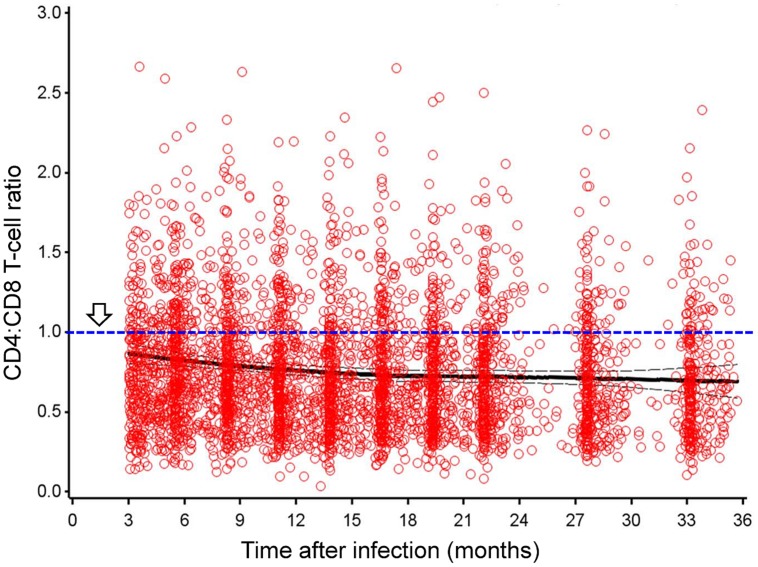
CD4:CD8 T-lymphocyte ratio in early human immunodeficiency virus type 1 (HIV-1) infection, in the absence of antiretroviral therapy. Results are shown for 499 seroconverters (SCs; native Africans) with 4,144 person-visits during the 3- to 36-month period after estimated date of infection. Thick and thin lines correspond to the mean ratio and 95% confidence interval (CI), respectively. Arrow points to the threshold of abnormal (inverted) ratio that is rarely seen in HIV-1 seronegative, healthy subjects.